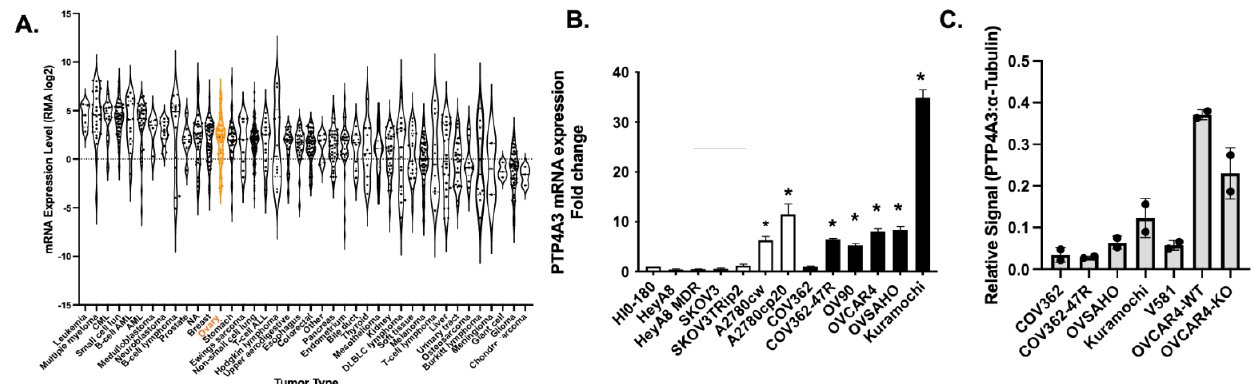
Figure 1. PTP4A3 is overexpressed in OvCa cell lines. ( A ) PTP4A3 mRNA expression in the Broad Cancer Cell Library Encyclopedia. Data obtained from https://portals.broadinstitute.org/ccle/. Ovarian cancers are indicated in orange. ( B ) PTP4A3 mRNA levels measured by qPCR and normalized to HPRT were elevated in all HGSOC cells lines (black columns) compared to HIO-180 nonmalignant epithelial cells grown in culture with the exception of COV362 cells. N = 3, bars = SEM. * p < 0.05 ANOVA. Supplementary Figure S1 demonstrates the differences are not associated with the HPRT reference gene product. ( C ) Detection of PTP4A3 protein in high grade serous OvCa cell lines. Fifty µg of total protein lysate was loaded per lane and protein levels were detected by Western blots with PTP4A3 antibody. Mean values of 2 technical replicates. Bars = range.